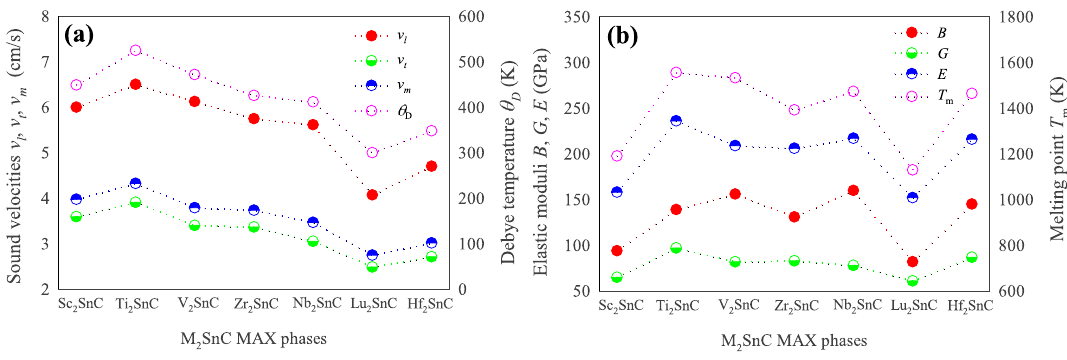
Figure 6. ( a ) Debye temperature with sound velocities; ( b ) melting temperature with elastic